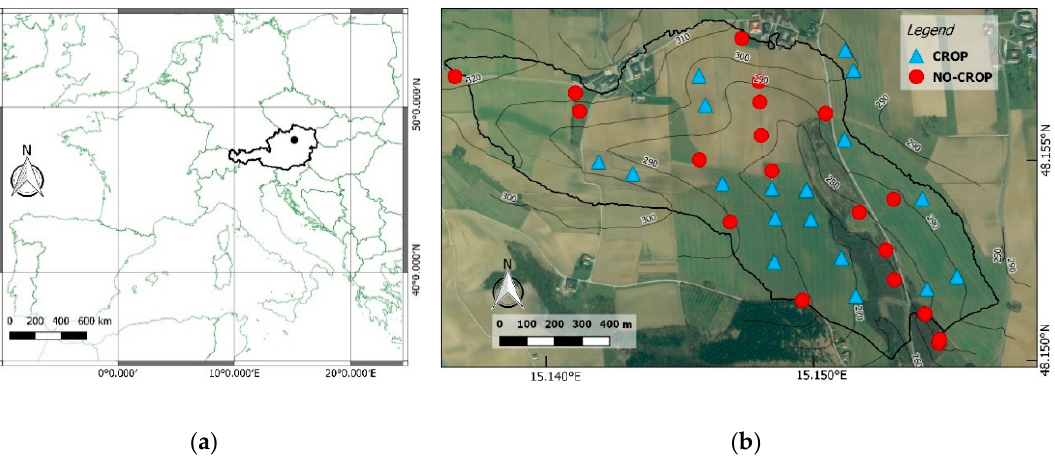
Figure 1. Location of the study area in Petzenkirchen, Austria ( a ) and distribution of the low-cost sensors within the study area ( b ). Map data © 2019 Bing.